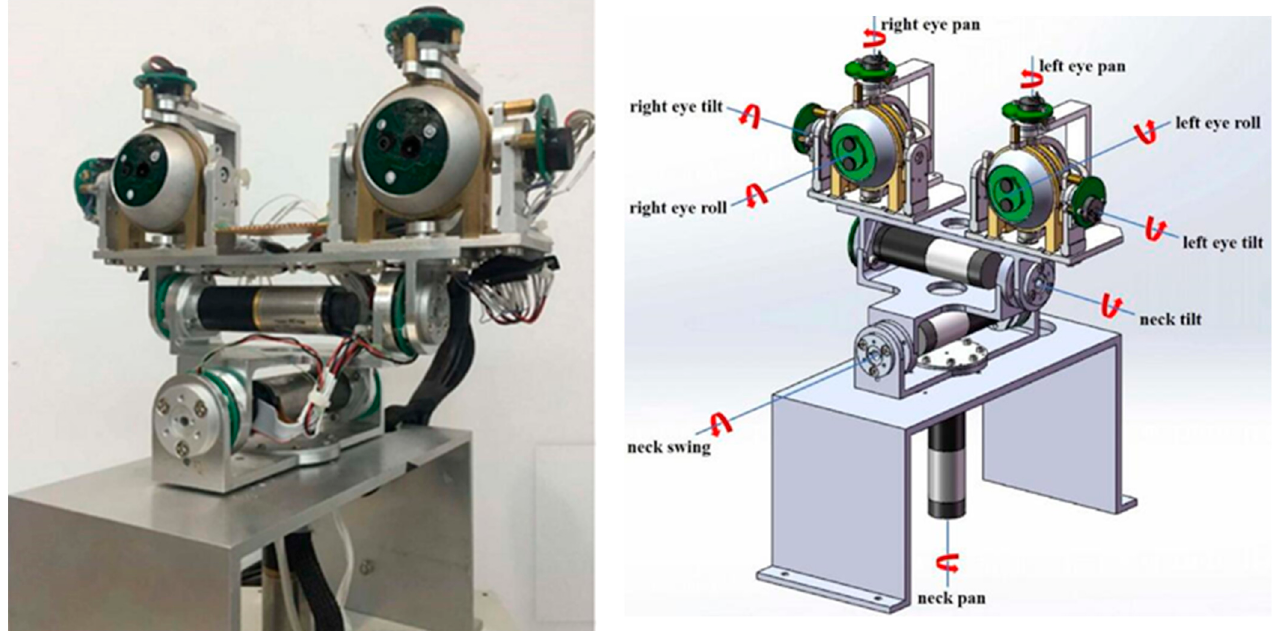
Figure 11. Bionic eye Vision Platform and Algorithm system. Copyright citation: This image is li- censed by IEEE.